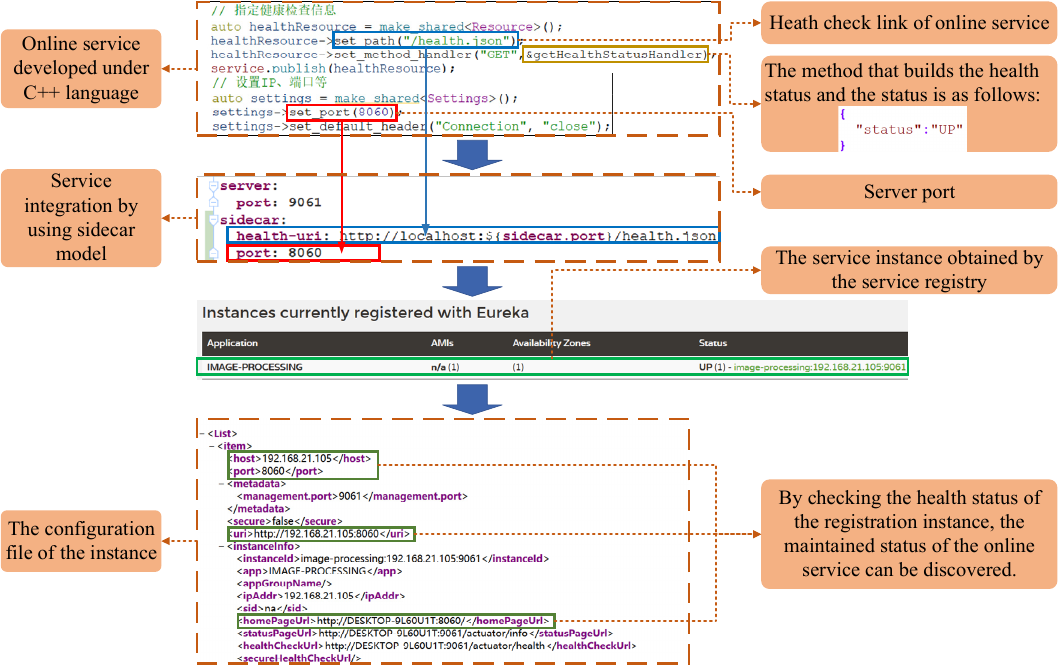
Figure 21. The integration of online services. Based on the unified access interface provided by the platform, users can use the instance of the online service through Service Gateway .